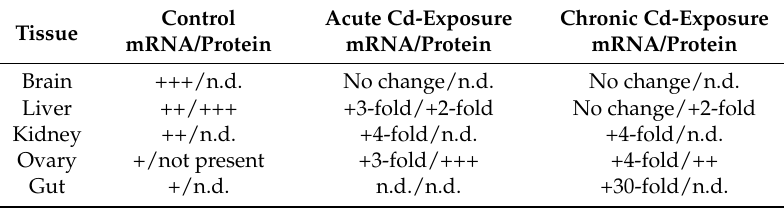
Table 1. Abundance of metallothionein transcript and protein in P. sicula tissues, under natural conditions and after in vivo